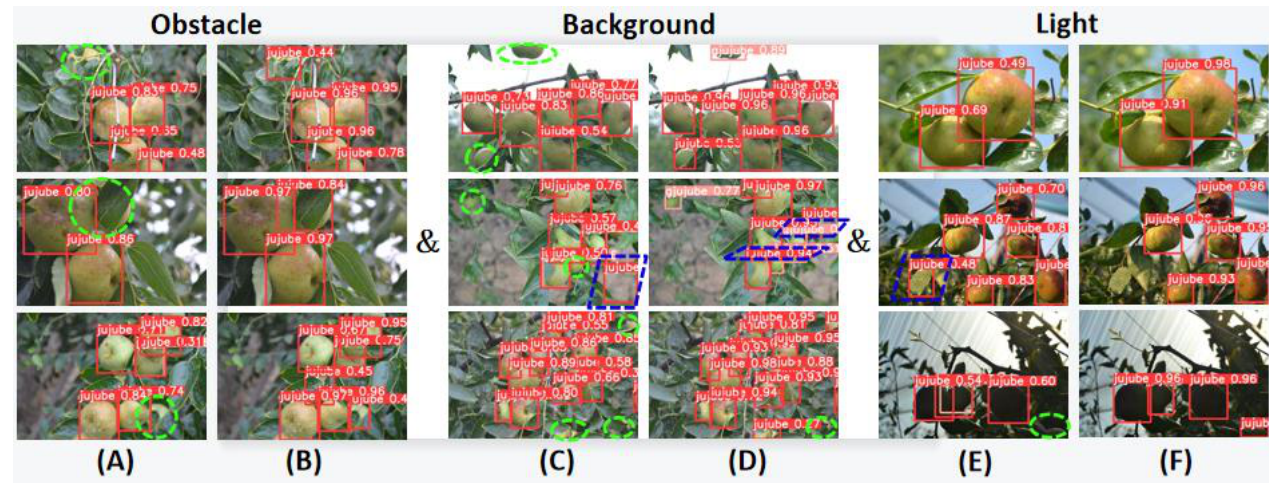
Figure 11. Identification effect of different algorithms under the different environments. ( A ,C,E) represent the identification effect of YOLOv5s algorithm. ( B , D , F ) represent the identification effect of YOLOv5-GCE algorithm. The different environments contain obstacle (branches, leaves, and jujube), background (soil, sky, and crown), and light (sunlight, sidelight, and backlight). The green and the blue dotted boxes indicate the missed and false detections, respectively.